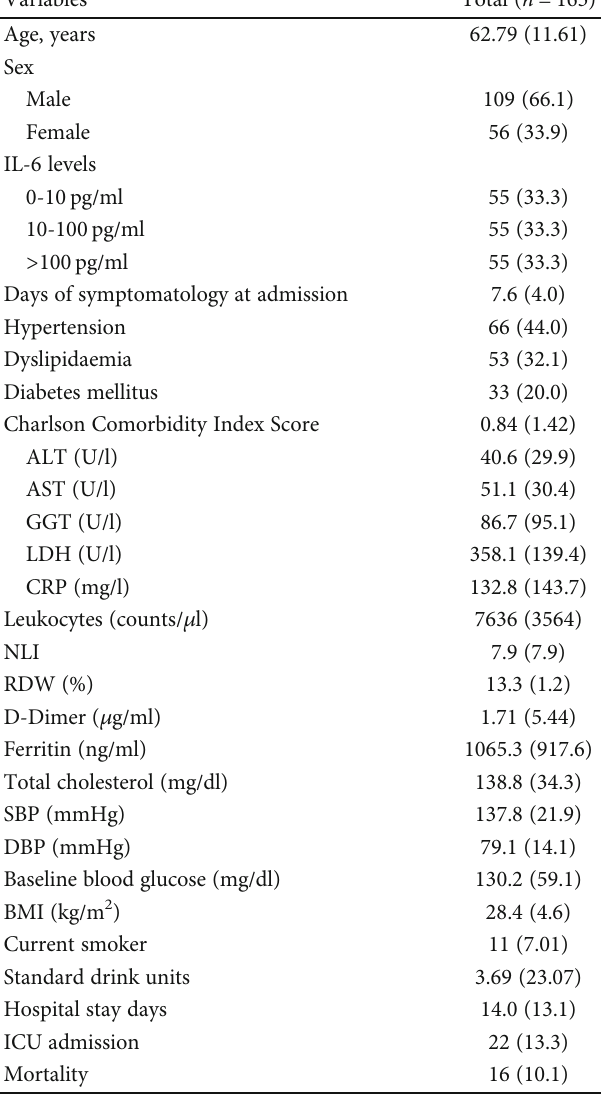
Table 1: Clinical features concerning the enrolled COVID-19